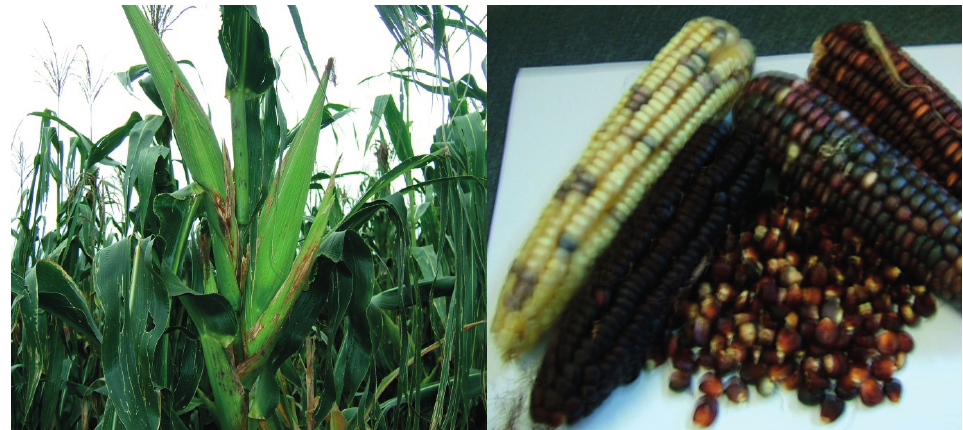
Figure 1. Maize landraces still show much variation with regard to seed colour and ear prolificacy. Source [10].